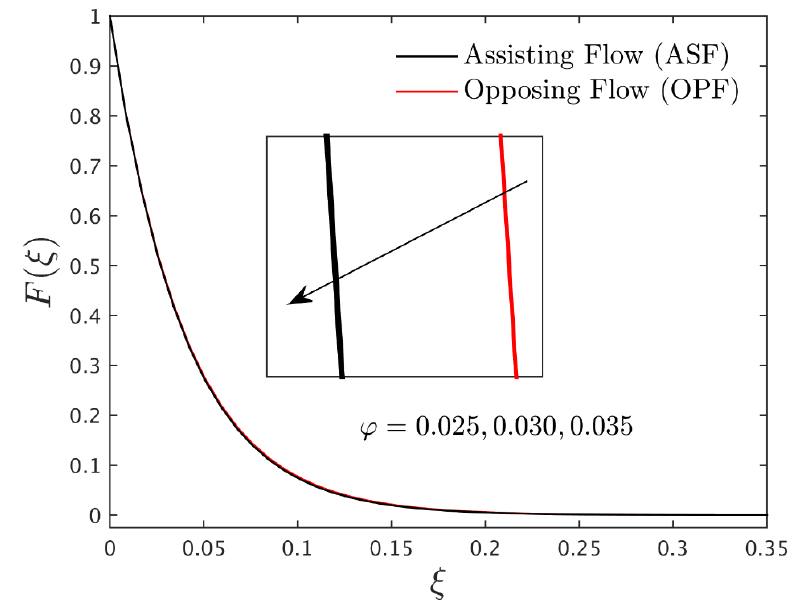
Figure 9. Concentration profile for the case of ASF and OPF due to variations in the values of ϕ .